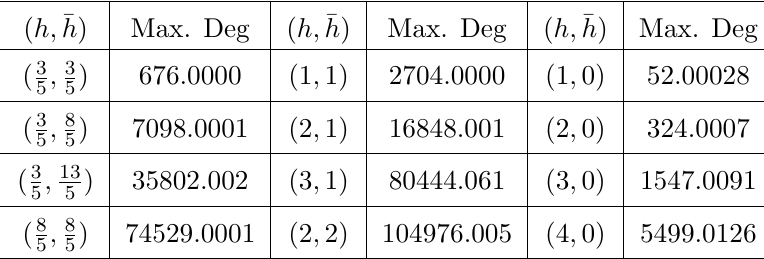
Figure 7. The extremal functional (cid:12) (cid:3) acting on spin-0 (left) and spin-1 (right) primaries at c = 26 and (cid:1) t = 6 . 5